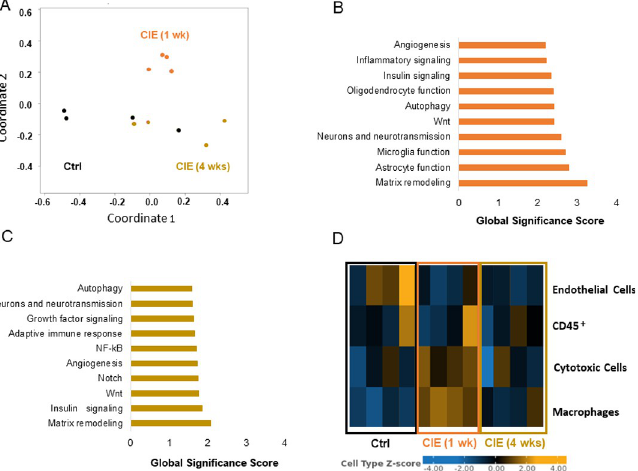
Fig 4. Cell type- and pathway-specific changes in the expression of the genes in the UB of control and CIE mice. A, A multi-dimensional scaling plot of the UB samples shows a different profile of gene expression in the CIE group at 1 wk post-infection, but less significant changes in gene expression between the control and CIE 4 wks group post- infection with a coronavirus. The coordinates on the axis are arbitrary. This plot is presented in a way of displaying similarities and differences between data points. Samples that are clustered together generally have similar patterns of expression. Global significance score (GSS) -based gene changes in the UB signaling pathways in CIE mice at 1 wk (B) and 4 wks (C) post-infection. D, Heat map of the UB genes clustered based on their expression levels in different cell types.